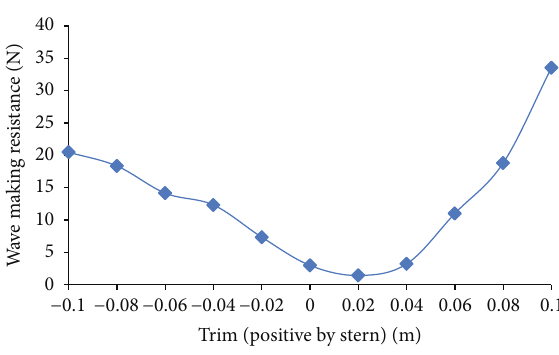
Figure 11: Wave making resistance as a function of trim.